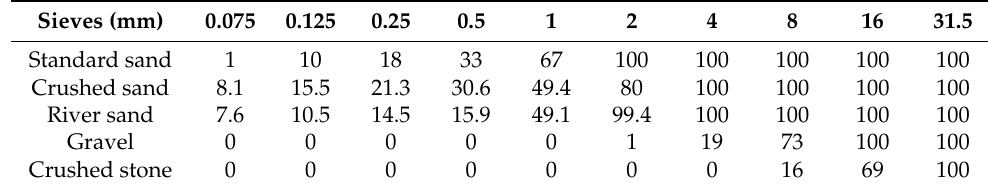
Table 2. Percentage passing through sieves for all aggregates.